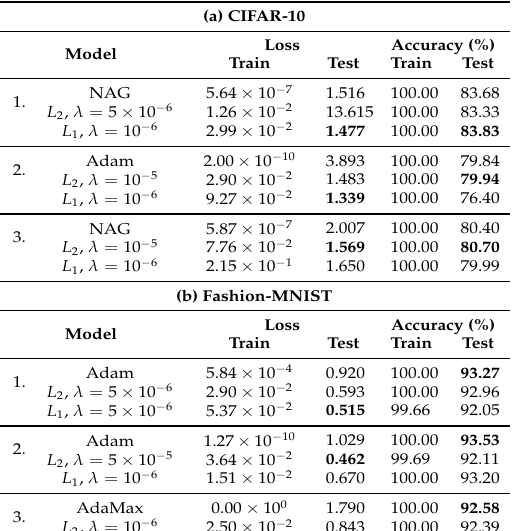
Table 5. Performance of models that use weight decay regularization.